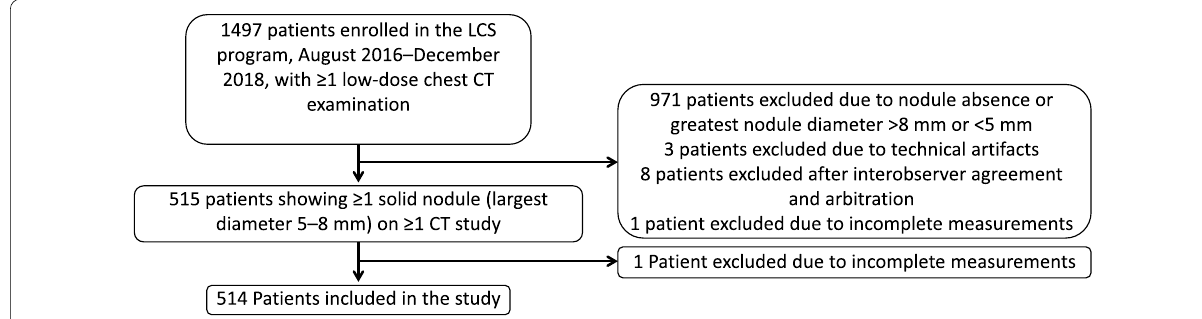
Fig. 3 Flow chart of patient selection and inclusion. LCS, lung cancer screening; CT, computed